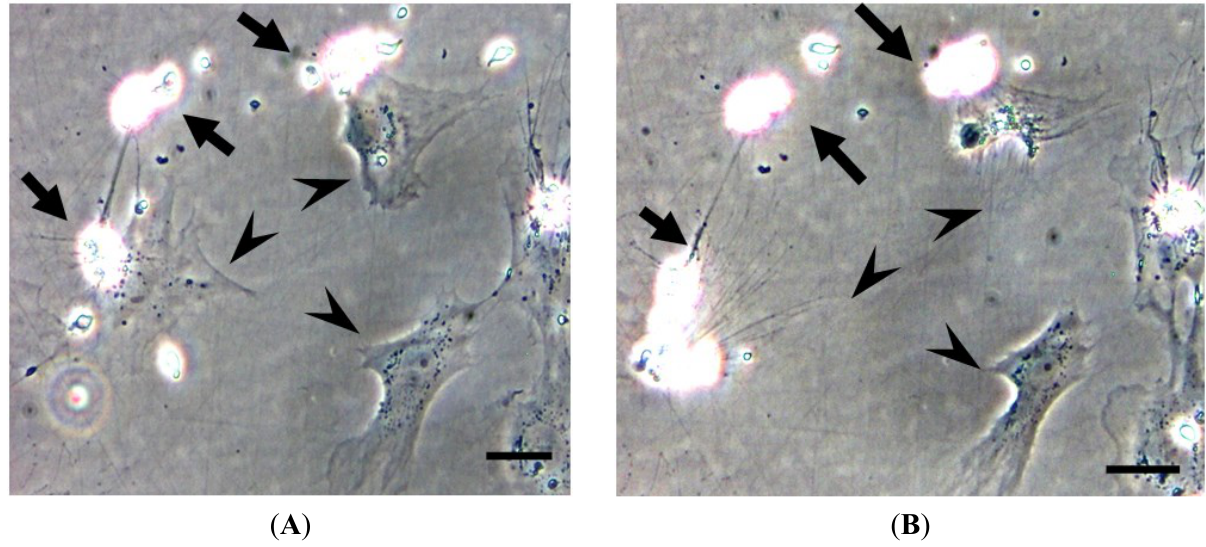
Figure 2. Killing of target cells by allo-sensitized CD8α + cells observed at 3 h ( A ) and 4 h ( B ). The arrow indicates aggregation of effector CD8α + cells. The arrowhead points to target CFS cell. Scale bar = 10 μm. Cited from